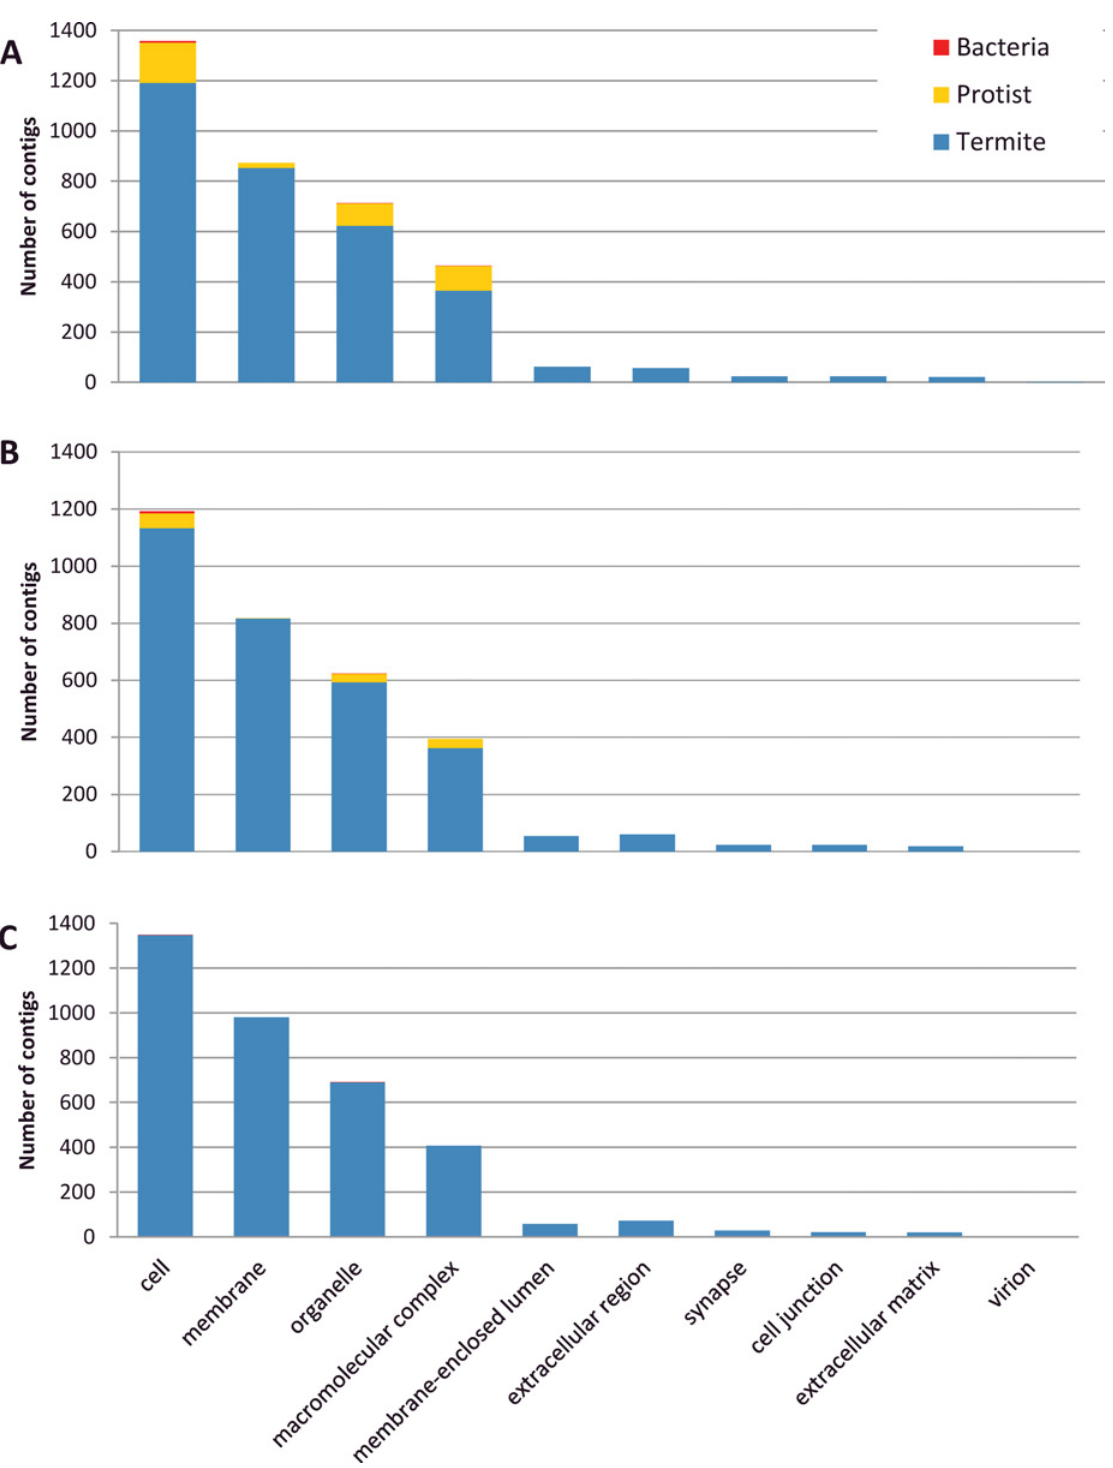
Fig 2. Gene Ontology analysis of Cellular Components (GO level 2). A: R . flavipes . B: R . grassei , C: R . lucifugus .